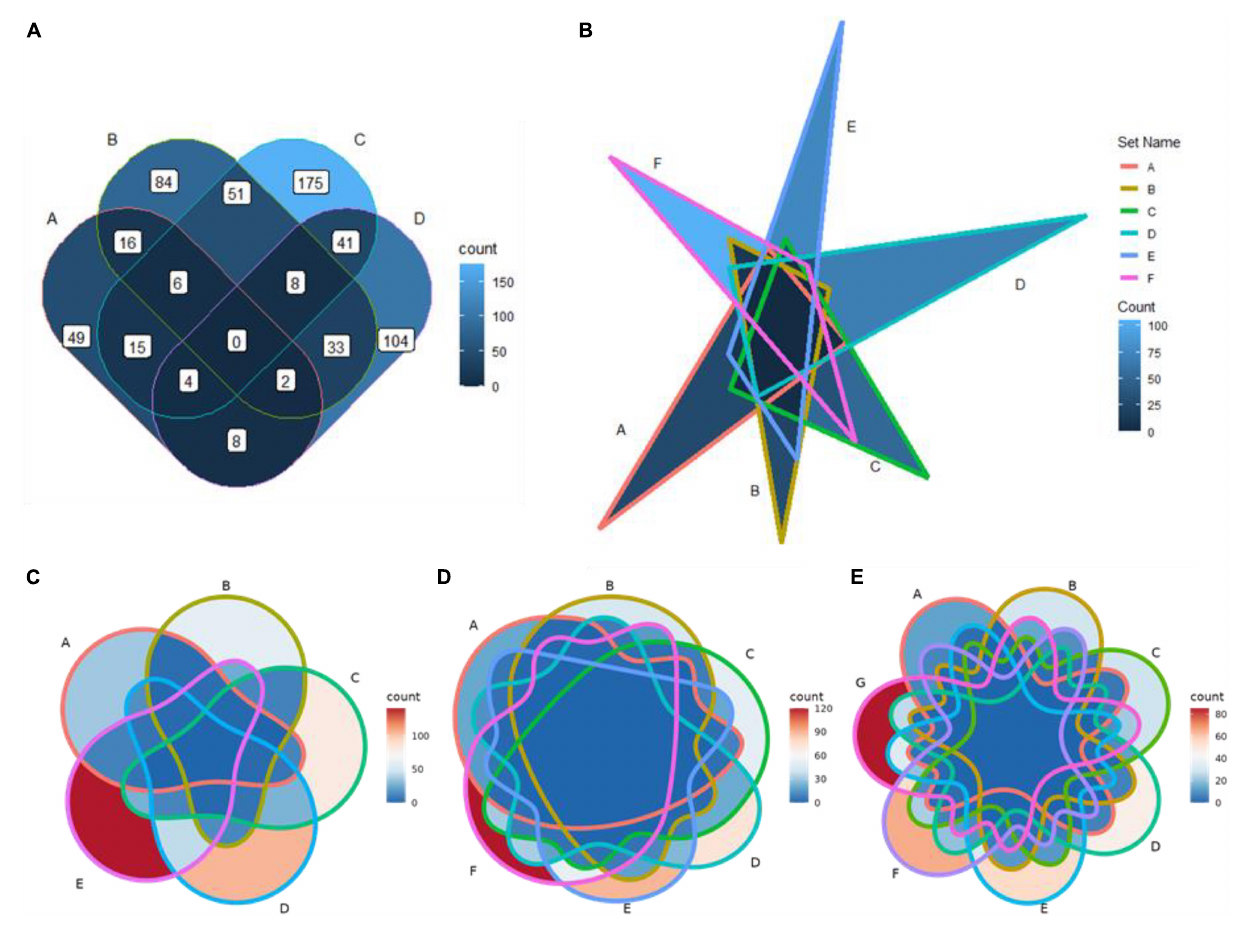
FIGURE 3 | Application of new shapes and support for a Venn diagram of up to seven sets in ggVennDiagram. (A) A rounded rectangle is used to plot a four-set Venn diagram. (B) A triangle is used to plot a six-set Venn diagram. (C–E) Five-, six-, and seven-set Venn diagrams plotted based on ggVennDiagram. The reproducible examples are available from the vignettes attached to the